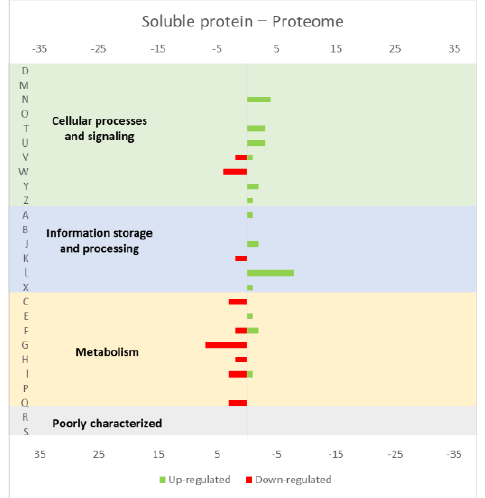
Figure 7. Effect of a heterologous protein overexpression in the L. lactis proteome profile. The graphs were constructed with compiled data from Kim et al. [29] and represent the total number of transcripts up or down-regulated in each cellular process. The letters on the yy axis correspond to the following COG categories: A, RNA processing and modification (not used for prokaryotic COGs), B, chromatin structure and dynamics, C, energy production and conversion, D, cell cycle control and mitosis, E, amino acid metabolism and transport, F, nucleotide metabolism and transport, G, carbohydrate metabolism and transport, H, coenzyme metabolism, I, lipid metabolism, J, translation, K, transcription, L, replication and repair, M, cell wall/membrane/envelope biogenesis, N, Cell motility, O, post-translational modification, protein turnover, chaperone functions, P, Inorganic ion transport and metabolism, Q, secondary metabolites biosynthesis, transport and catabolism, T, signal transduction, U, intracellular trafficking and secretion, Y, nuclear structure (not applicable to prokaryotic COGs), Z, cytoskeleton (not applicable to prokaryotic COGs); R, general functional prediction only (typically, prediction of biochemical activity), S, function unknown [35,36].